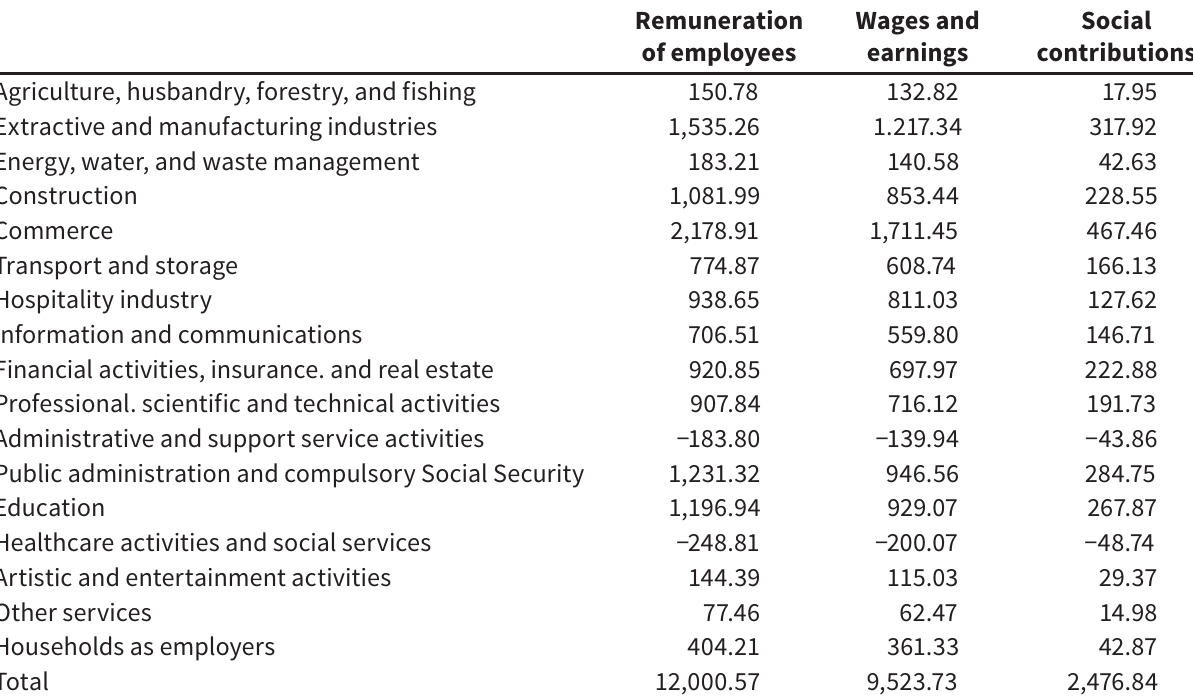
Remuneration of employees in the new jobs created in the transition with respect to the scenario with no exclusion (millions of